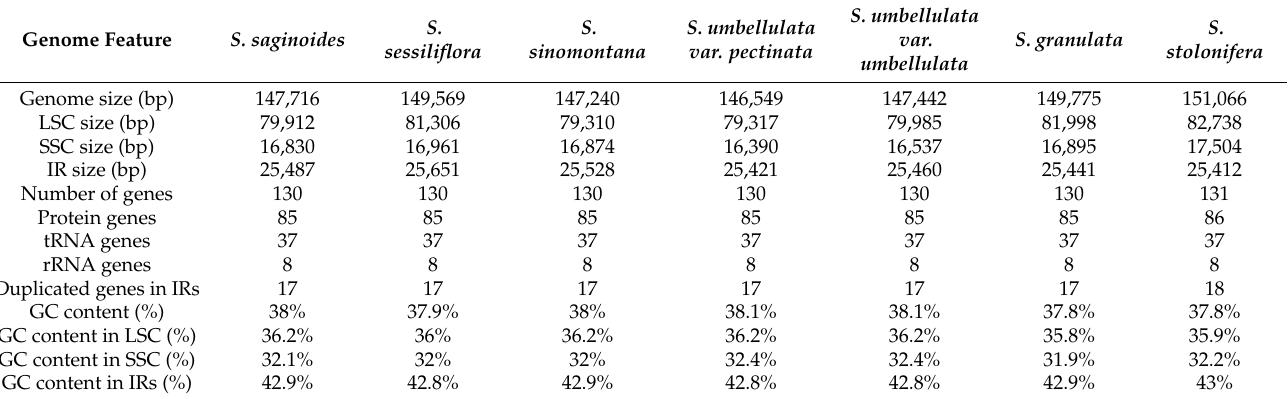
Figure 1. cp genome map of two newly sequenced Saxifraga species, S. saginoides and S. sessiliflora . The outer circle shows the transcription direction; genes outside are transcribed clockwise while genes inside are transcribed counterclockwise. LSC/SSC/IR regions are exhibited in the inner circle. Genes of different functions are presented in different colors. Table 2. Summary statistics of chloroplast genomes for Saxifraga